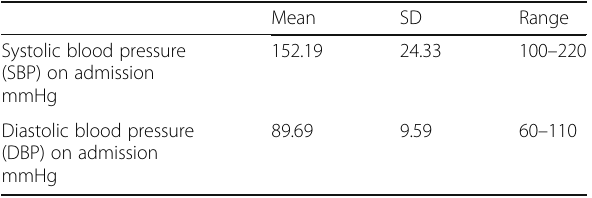
Table 2 Mean systolic and diastolic blood pressure on admission